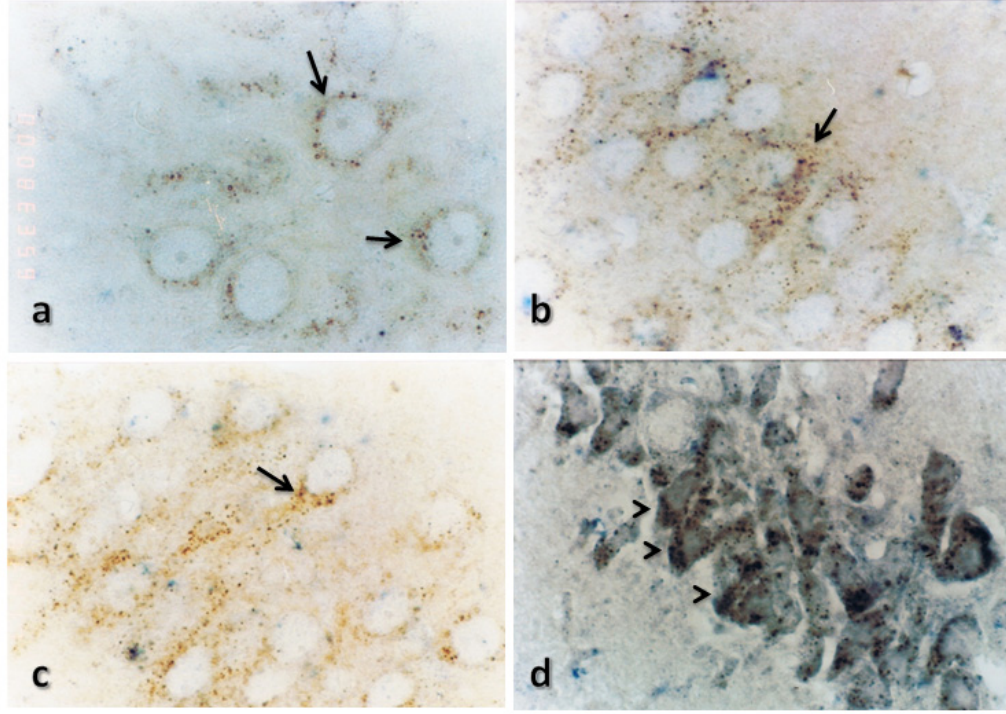
Figure 8. Effect of TBI on the immunoreactivity of cathepsin B and CC in CA1 region of hippocampus. Representative micrographs showing the change in the immunoreactivity of cathepsin B (brown) and CC (purple) in rats killed either before TBI ( a ) or at 24 ( b ), 48 ( c ) or 72 ( d ) h after TBI. Cathepsin B was detected in control rats, and the expression level increased 24 h after TBI and decreased after 72 h, whereas CC was detected 48 h after TBI. Damaged cells show an intense immunoreactivity for cathepsin B, which has lost its lysosomal distribution. Magnification: 100× Arrows indicate cathepsin B staining, and arrowheads indicate cystatin C